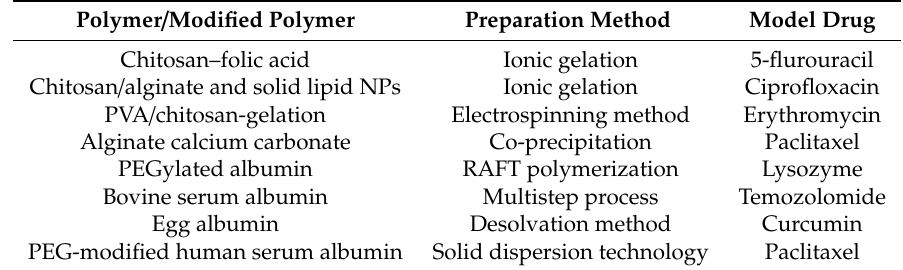
Table 2. Shows the modified chitosan-, alginate-, and albumin-based nano polymer for drug delivery systems